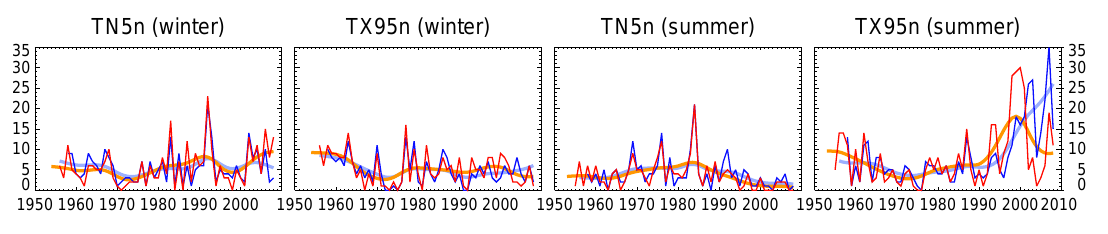
Fig. 2. Comparison of TN5n and TX95n extreme temperature indices for Athens domain based on E-OBS and ERA-40 temperature